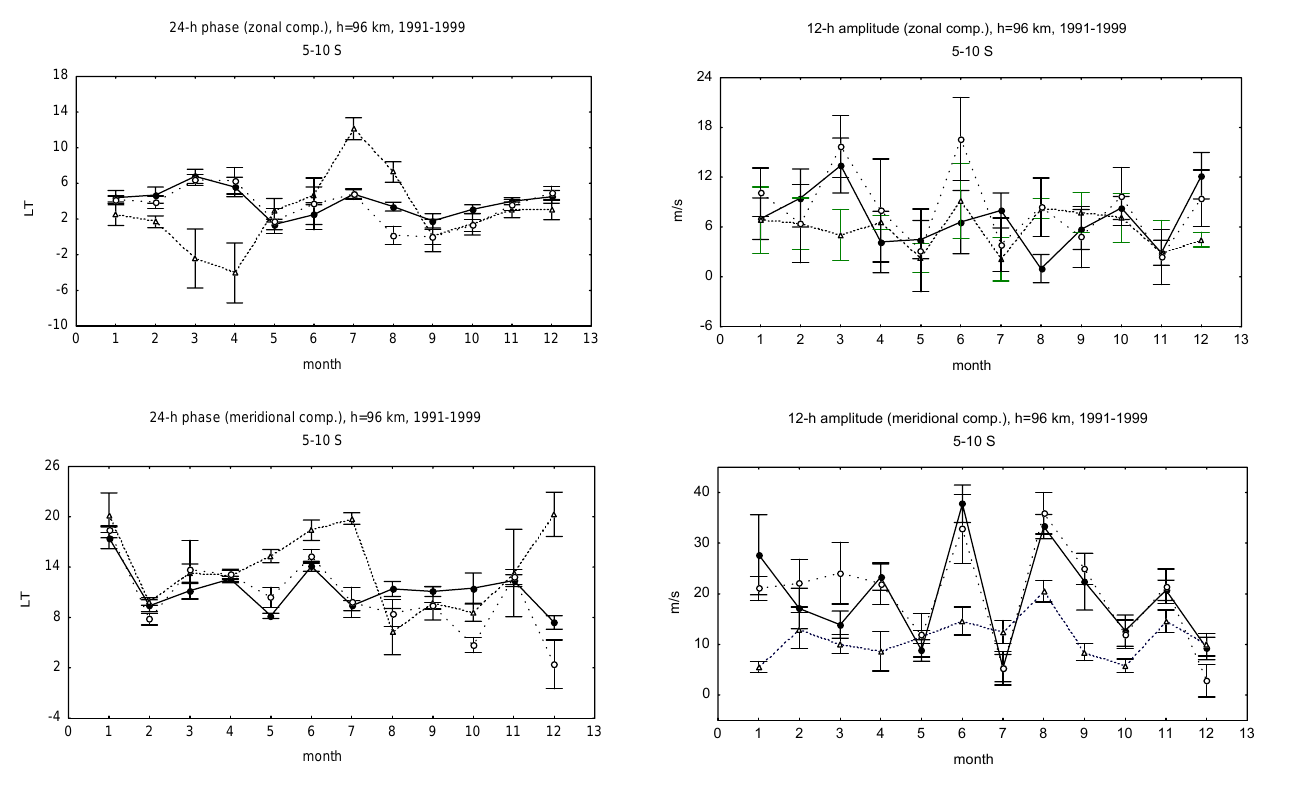
Fig. 18. Same as Fig. 16, except for phase of diurnal tide. Fig. 19. Same as Fig. 16, except for amplitude of semidiurnal tide.